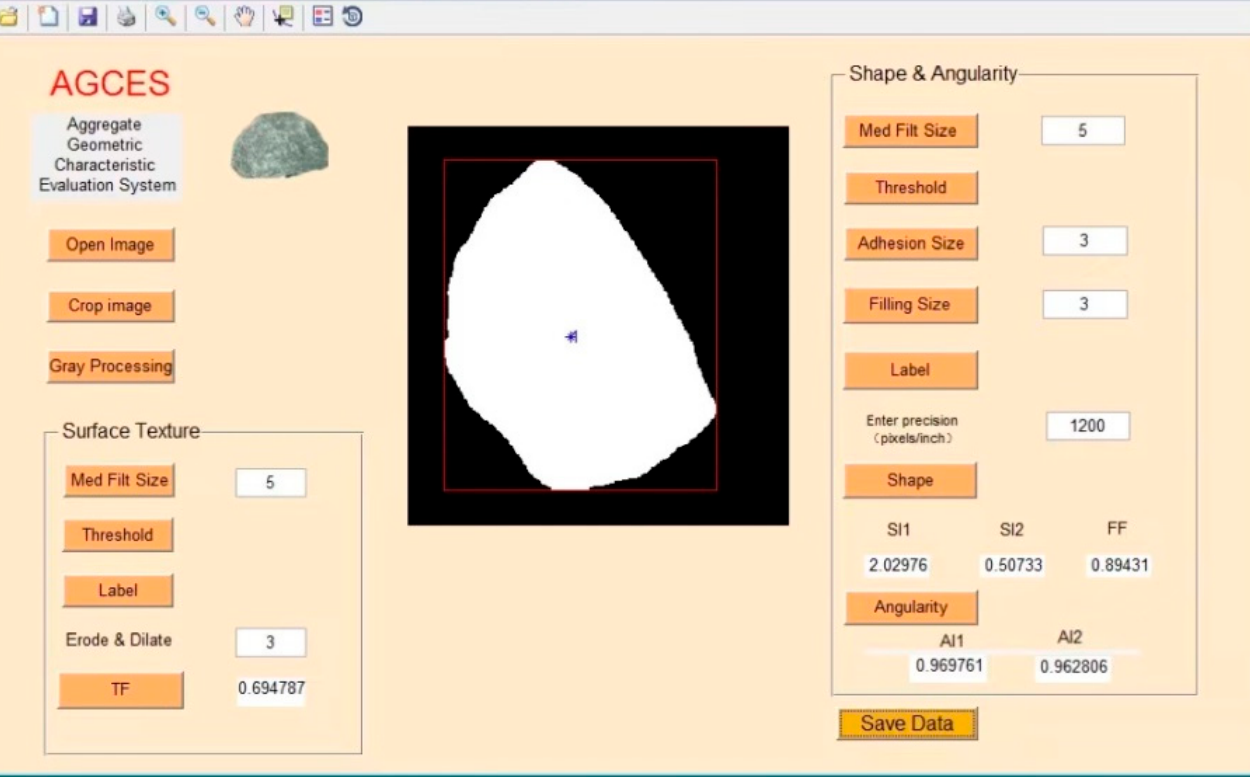
Figure 4. Sensitivity analysis of WFT to micro-texture.